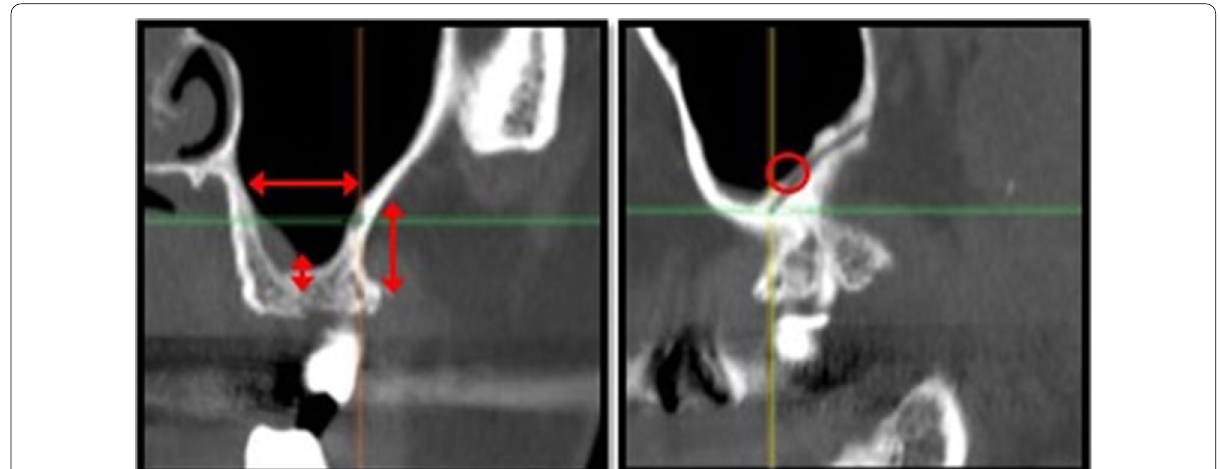
Fig. 4 Viewing and measuring the PSAA in MPR format (axial and sagittal planes). Horizontal and vertical measures related to PSAA